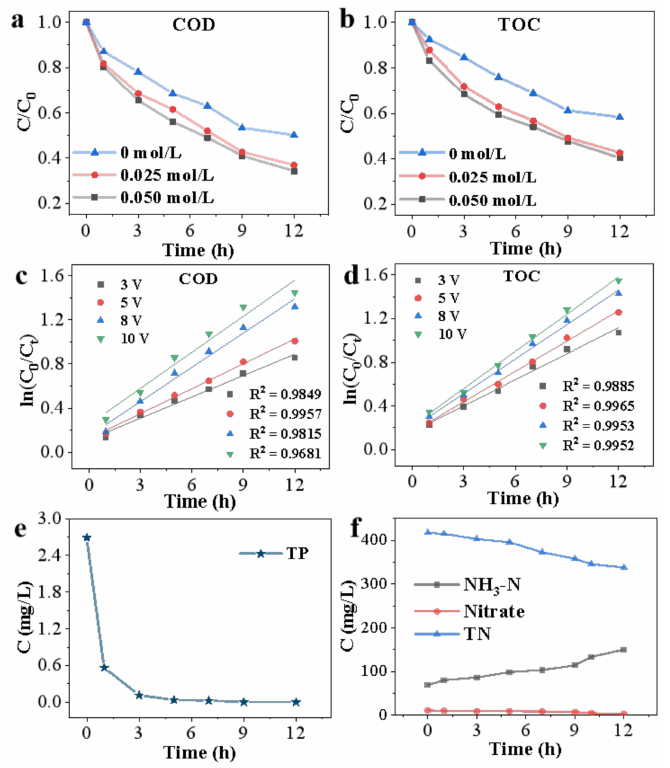
Figure 3. ( a , b ) Effect of the Na 2 SO 4 concentration on the COD and TOC removal percentage. ( c , d ) The kinetics of COD and TOC removal at different voltages. ( e , f ). The TP concentration changes with time and the NH 3 -N, nitrate and TN concentrations change with